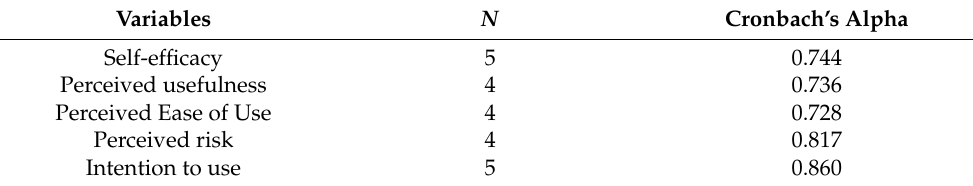
Table 3. Cronbach’s alpha test